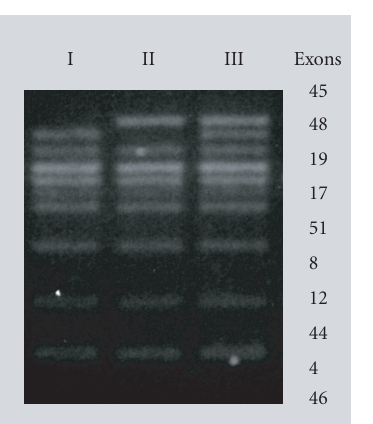
Figure 2. Schematic representation of di ff erent deletions in the dystrophin gene as detected in Moroccan patients (horizontal lines). The top numbers indicate the amplified exons. The arrow indicates the most frequent dele-